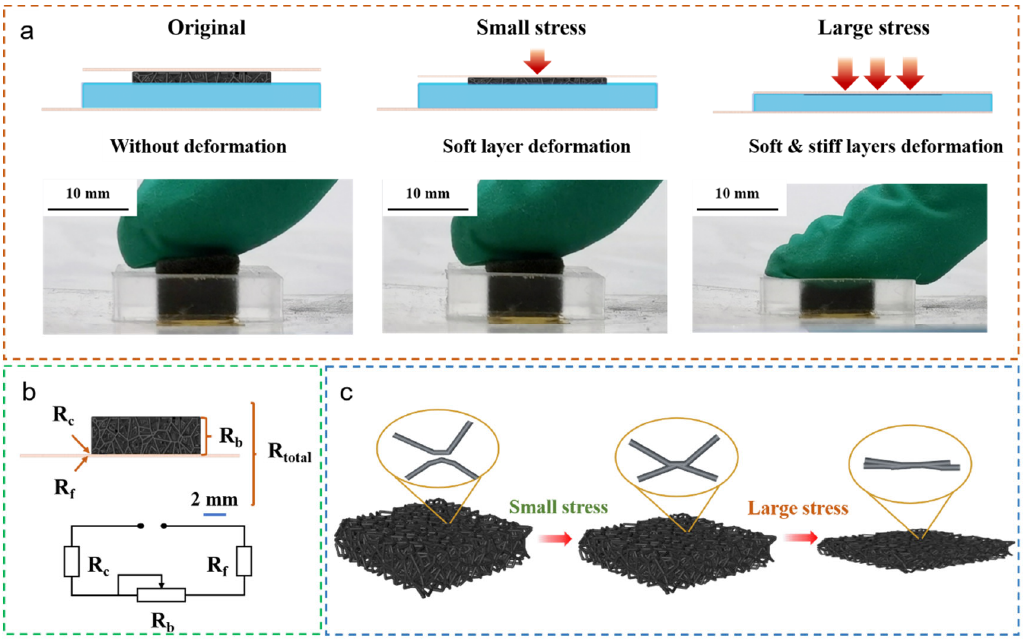
Figure 3. ( a ) Schematic and pictures of different amounts of compressive strain of HMFPS; ( b ) The equivalent circuit model of the HMFPS; ( c ) Schematics of the sensing mechanism of the HMFPS.